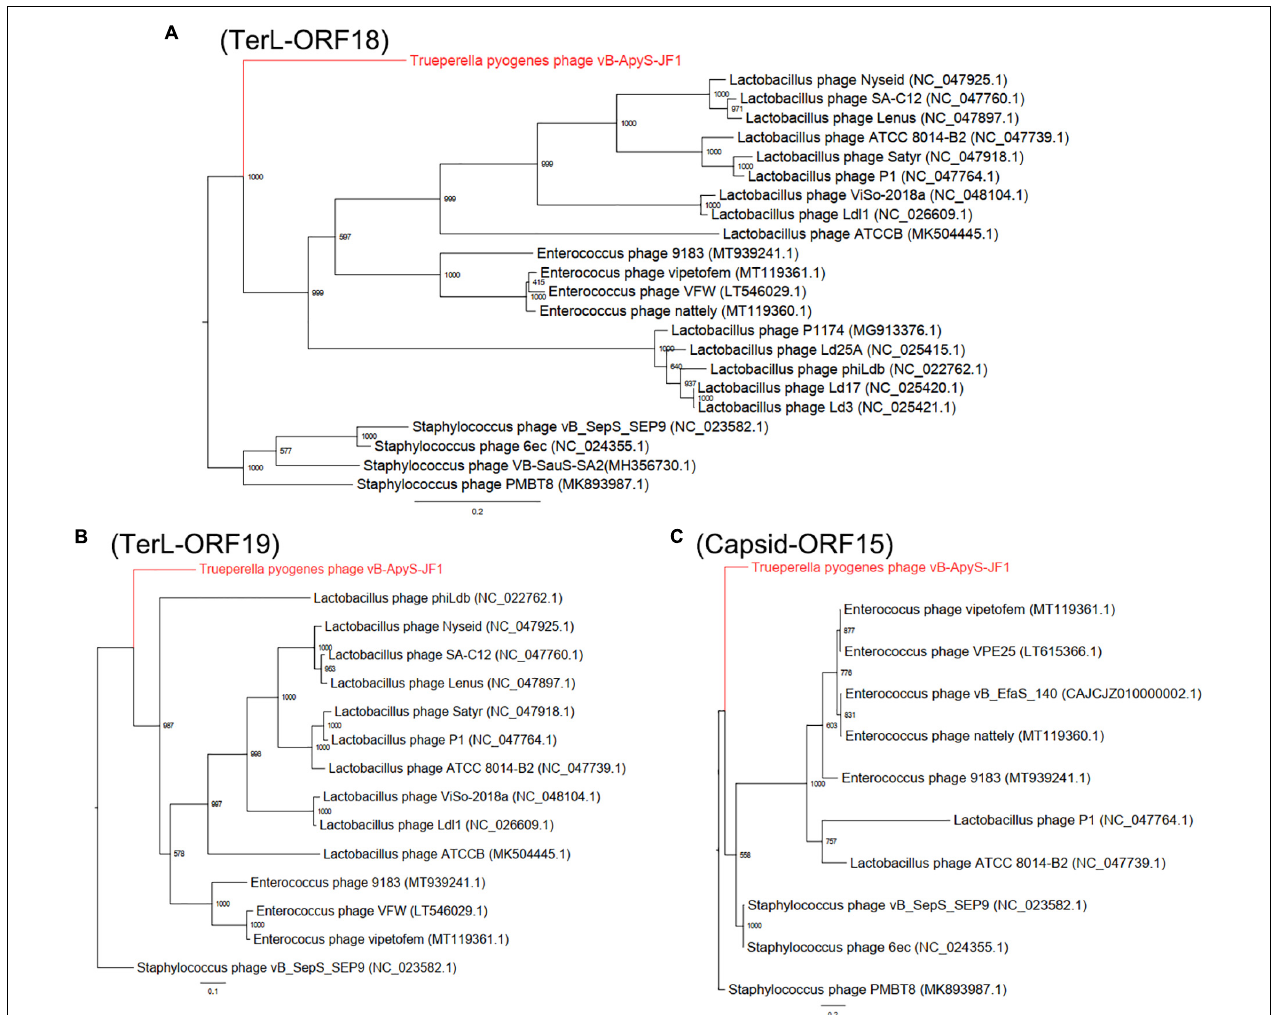
FIGURE 4 | Phylogenetic trees were generated using the maximum likelihood (ML) method with 1,000 bootstrap replicates. (A) Phylogenetic tree based on the DNA of the terminase large subunits (ORF18) of JF1. (B) Phylogenetic tree based on the DNA of the terminase large subunits (ORF19) of JF1. (C) Phylogenetic tree based on the DNA of the capsid protein (ORF15) of